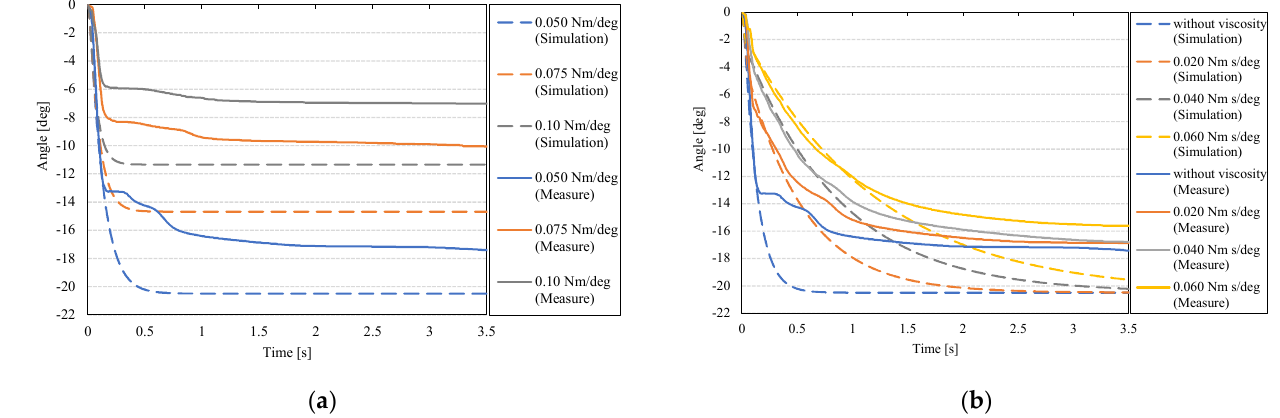
Figure 19. Simulation and measurement results of load removal experiment. ( a ) Result of angle (joint stiffness). ( b ) Result of angle (joint viscosity).